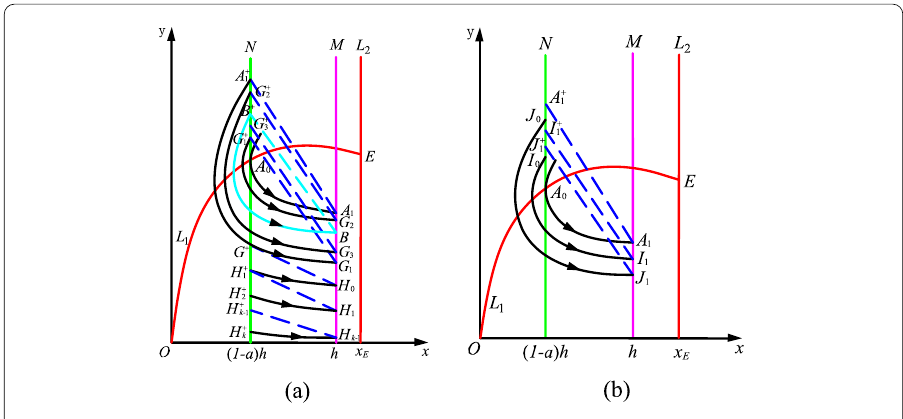
Figure 6 The schematic of the attractiveness of the order-1 periodic solution with conditions 0 < (1 – a ) h < h ≤ x E < K and y A uniqueness of the order-1 periodic